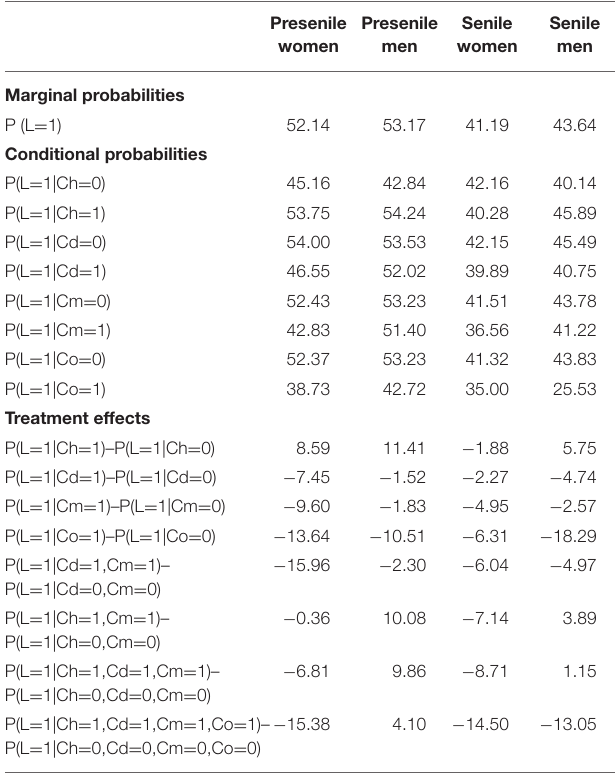
TABLE 6 | Predicted labor force participation probabilities